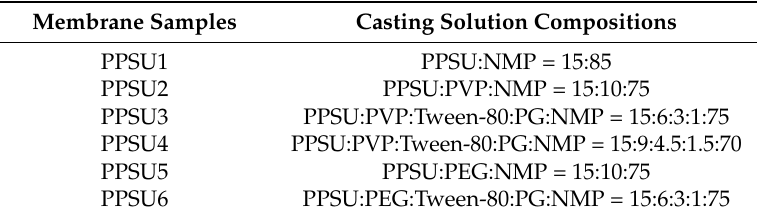
Table 2. Casting solution compositions of PPSU